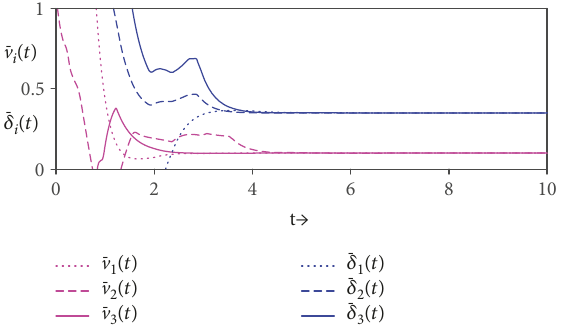
Figure 3: Parameter identi fi cation of the system (4) – (7): lim t = α 1